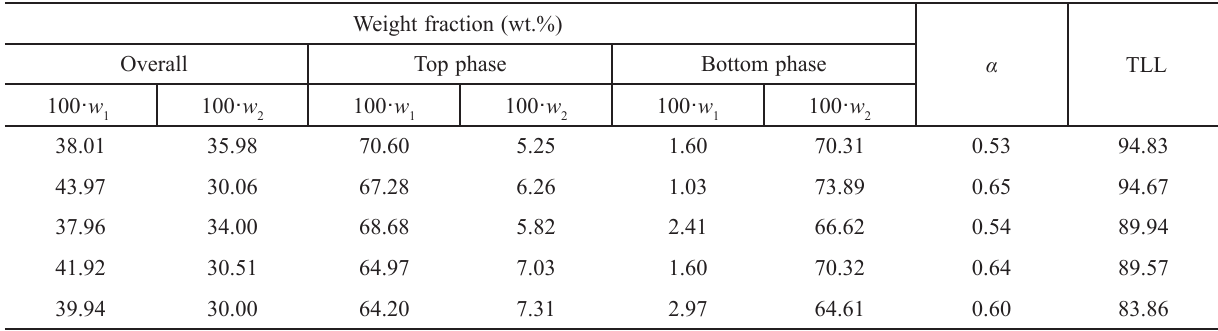
Weight fraction (wt.%)